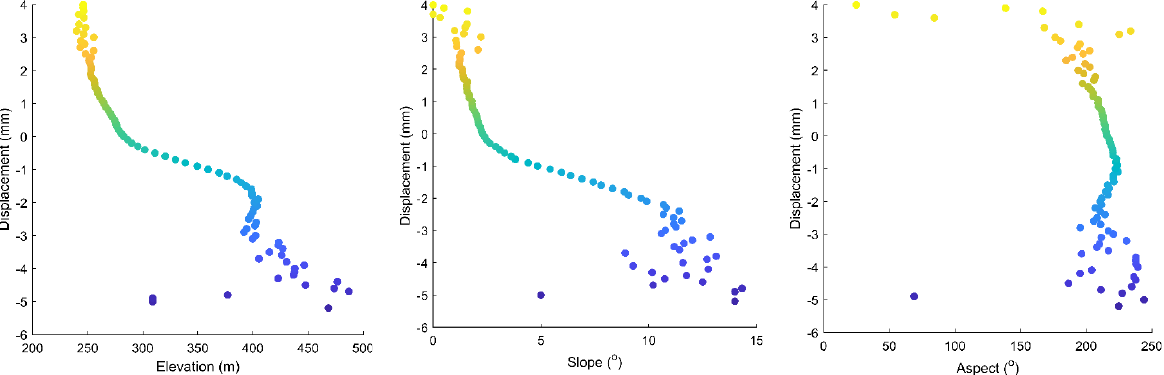
Figure 12. The variation of displacement with respect to the mean values of the elevation, slope, and aspect in the study area.